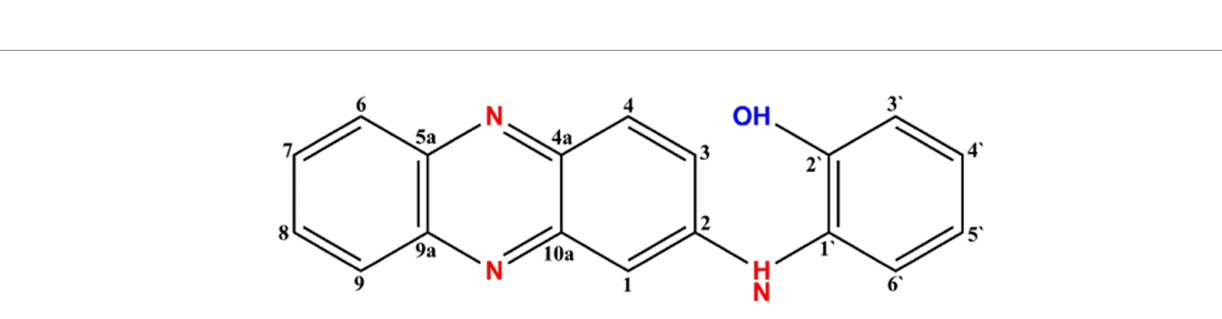
FIGURE 4 | Structure of NHP and the molecular weight of NHP was found to be